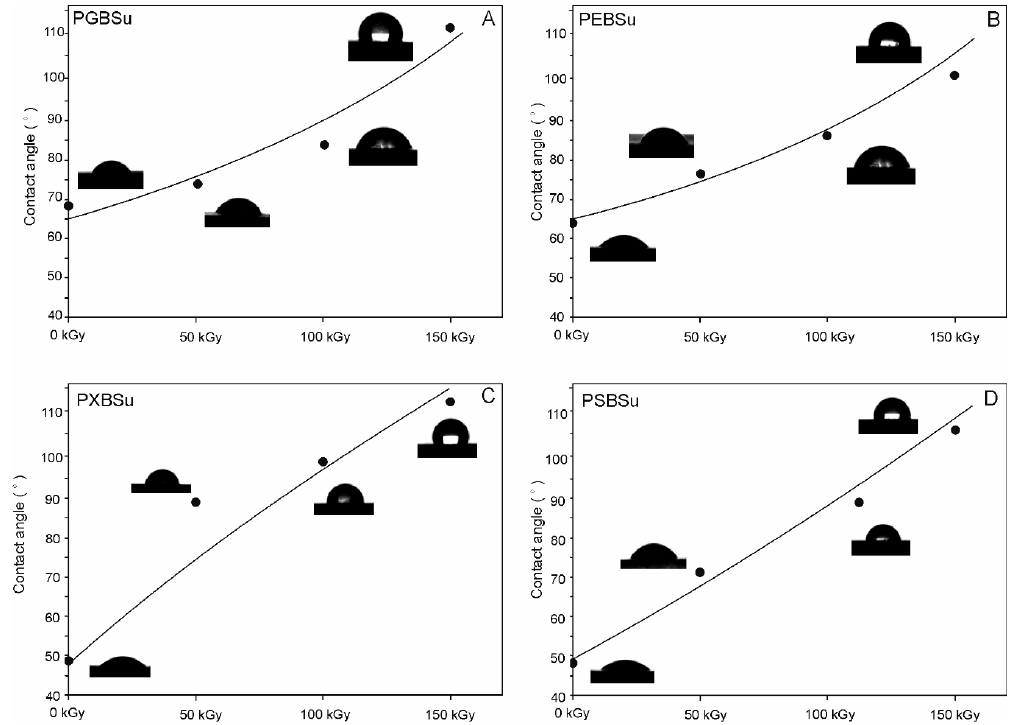
Figure 9. ( A ) PGBSu, ( B ) PEBSu, ( C ) PXBSu, and ( D ) PSBSu water contact angle before and after irradiation. after